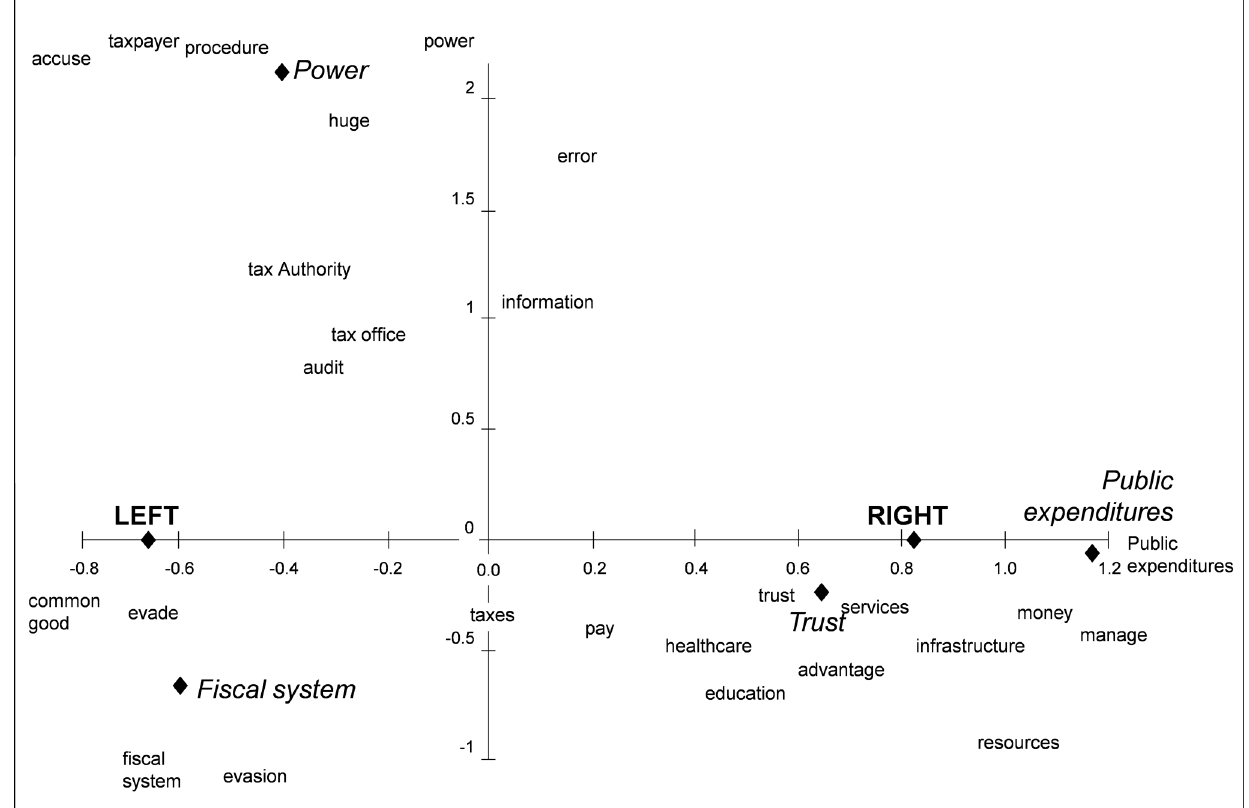
Figure 3. Two-dimensional solution of multiple correspondence analysis. The map shows the positions and association between the variables (in capital bold: political preferences, in italics: the thematic code) and the semantic units. For further explanations, see Note